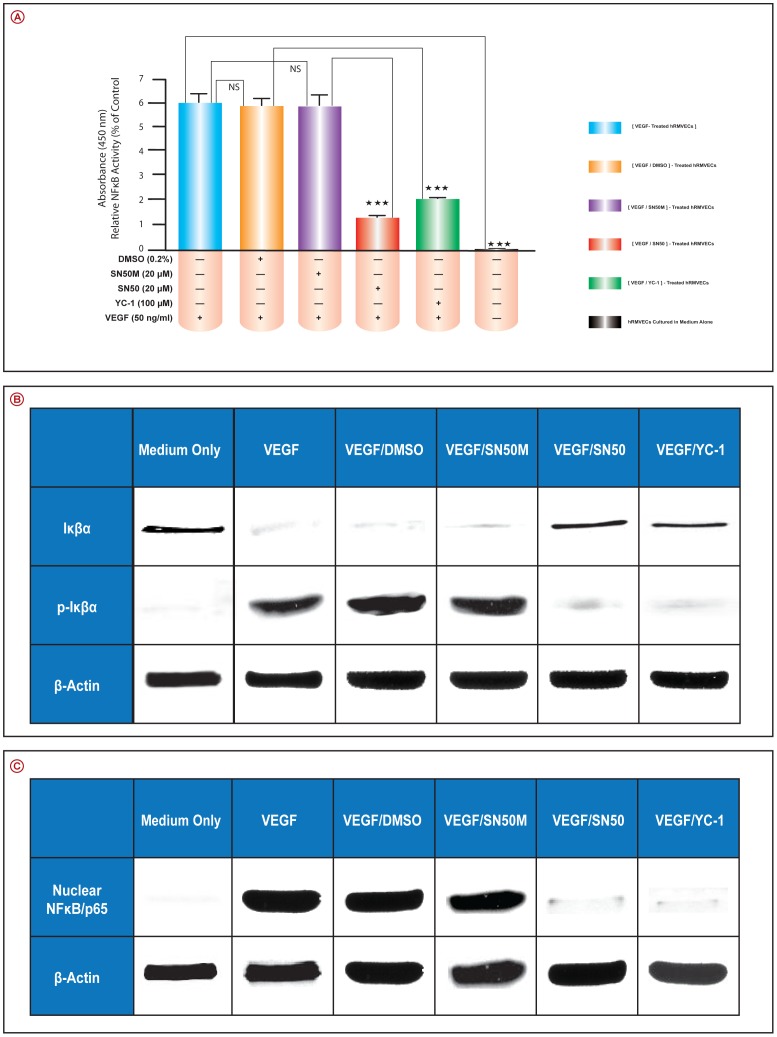
YC-1 Impairs VEGF-Induced NFκB Activation by Inhibiting IκBα Phosphorylation in VEGF-Treated Cells.
A. The Influence of YC-1 on VEGF-Induced NFκB Transcriptional Activity.The graph illustrates the suppression of NFκB Activation by YC-1 in hRMVECs. ELISA assay was done after 18 hours of incubation with YC-1. Columns represent the means derived from three individual experiments. [*P<0.05; **P<0.01; ***P<0.001, as compared with controls. B. Inhibition of IκBα Phosphorylation and Accumulation of IκBα by YC-1. Cells were incubated in the absence or presence of 100 µl YC-1 for 8 hours. Cell extracts were then subjected to Western blotting using IκBα and p- IκBα antibodies. The blots exhibit the inhibitory influence of SN50 and YC-1 on the expression of the phosphorylated form of IκBα. C. The Effects of YC-1 on Intranuclear Expression of NFκB/p65. Cells were treated with one of the following conditions; DMSO, SN50M, SN50, or YC-1 in the presence or absence of VEGF for 8 hours. Nuclear extracts were prepared and assayed for NFκB/p65 by Western-blot as described in materials and methods. Both SN50 and YC-1 specifically inhibited the intranuclear expression of NFκB/p65 in cell preparations.